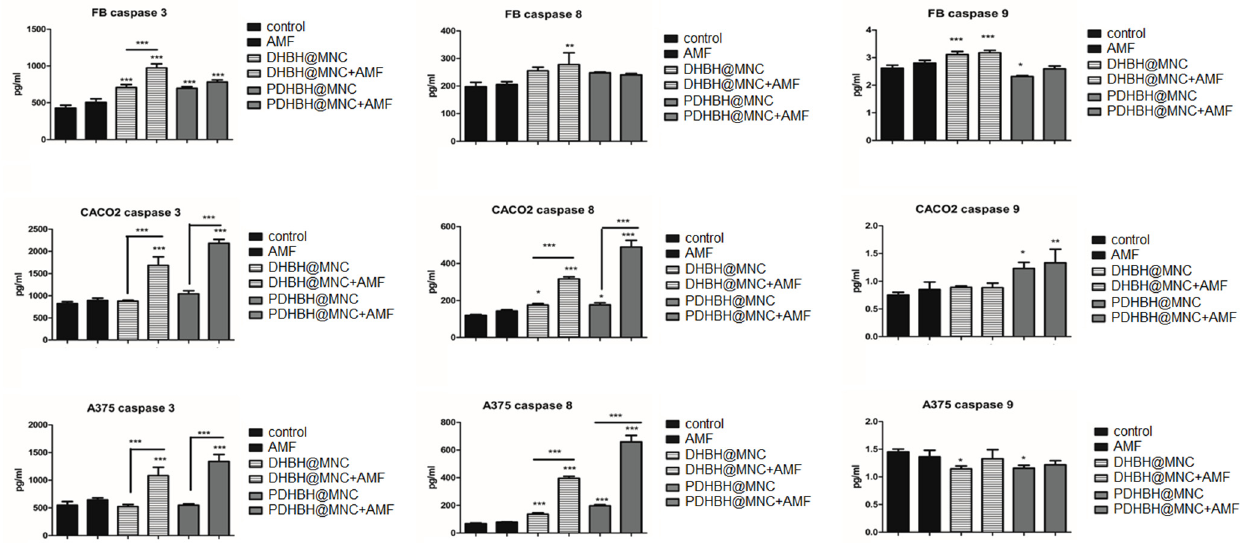
Figure 10. Caspase 3, 8, and 9 of cells (fibroblasts (BJ), upper panels; colon adenocarcinoma (CACO2), middle panel; and melanoma (A375), lower panel) measurements through ELISA. Results are expressed as pg/mL. Each bar represents mean ± standard deviation (n = 3); * = p < 0.05, ** = p < 0.001, *** = p < 0.0001, control versus treated group (cells exposed to AMF, incubated with MNC with and without MH exposure) for each cell line.